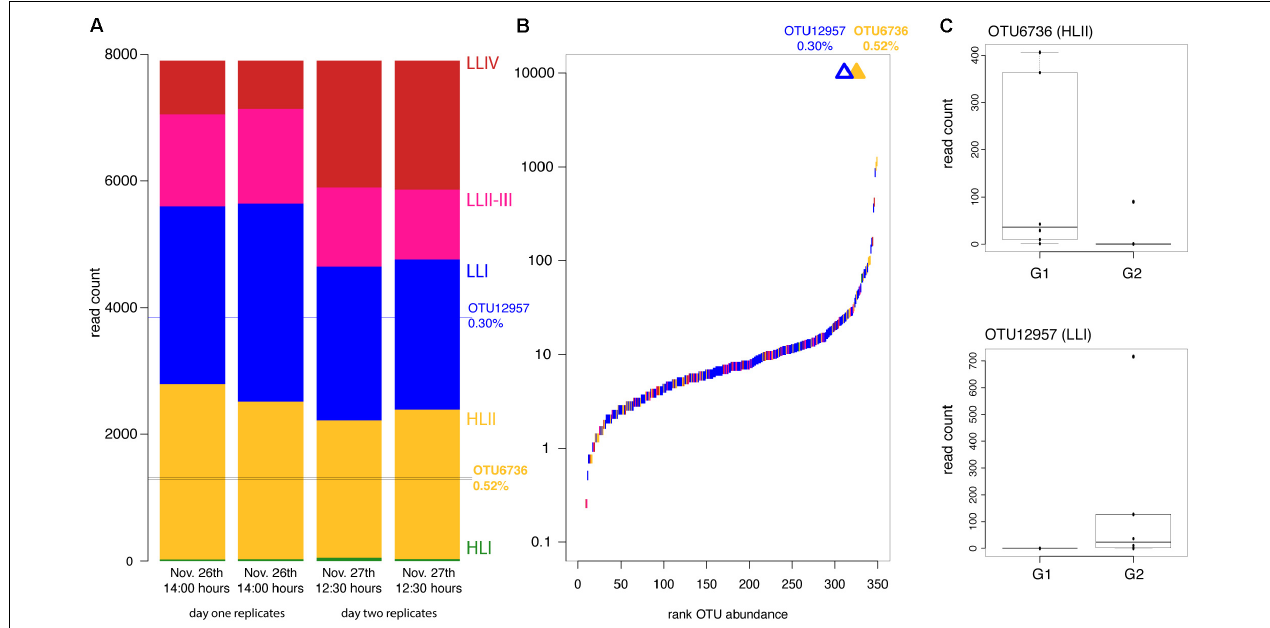
FIGURE 1 | Prochlorococcus ecotype and OTU abundance during the cell cycle analysis experiment. (A) Ecotype composition of replicate whole seawater samples from the two time-points (November 26th and 27th) prior to cell division at 12:30–14:00 h, when all cells were present in the G1 phase. (B) Rank abundance of OTUs across the time-course with OTUs enriched (open) or depleted (filled) in the G2 phase marked by triangles matched to their rank abundance. Colors indicate the ecotype identity of each OTU according to colors in (A) . (C) Boxplots of read counts from replicate samples from G1 and G2 populations for the differentially abundant OTUs. TABLE 1 | Ecotype identity and percent total sequences of differentially abundant OTUs for the cell cycle and DNA-SIP incubation experiments. Experiment Result